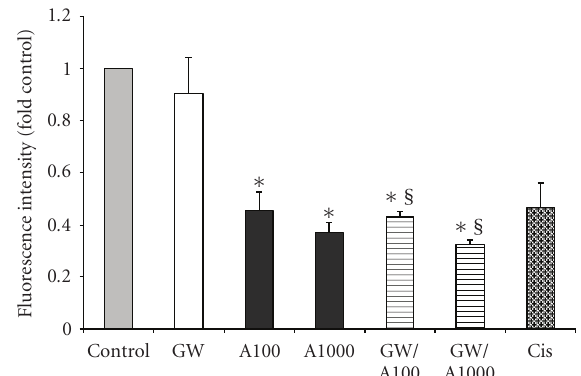
Figure 8: GW501516 has no e ff ect on anisomycin-induced cell death. Serum-starved cells were stimulated with serum-free media (control), 10 − 6 M GW501516 (GW), 100 and 1000 ng/mL ani- somycin (A100 and A1000, resp.), or 50ng/mL cisplatin (Cis) for 18 hours. Some of the cells treated with anisomycin were pretreated with 10 − 6 GW501516 for 24 hours and cotreated with the agonist and anisomycin for 18 hours (GW/A100 and GW/A1000). The cells were then incubated for one hour with the DNA dye- binding solution from the CyQUANT NF assay kit (Invitrogen). Fluorescence intensity, representing number of cells, was then measured as per the manufacturer’s instructions. Values are means ± S.E.M.; n = 3. ∗ P < . 05 compared to control; § P < . 05 compared to